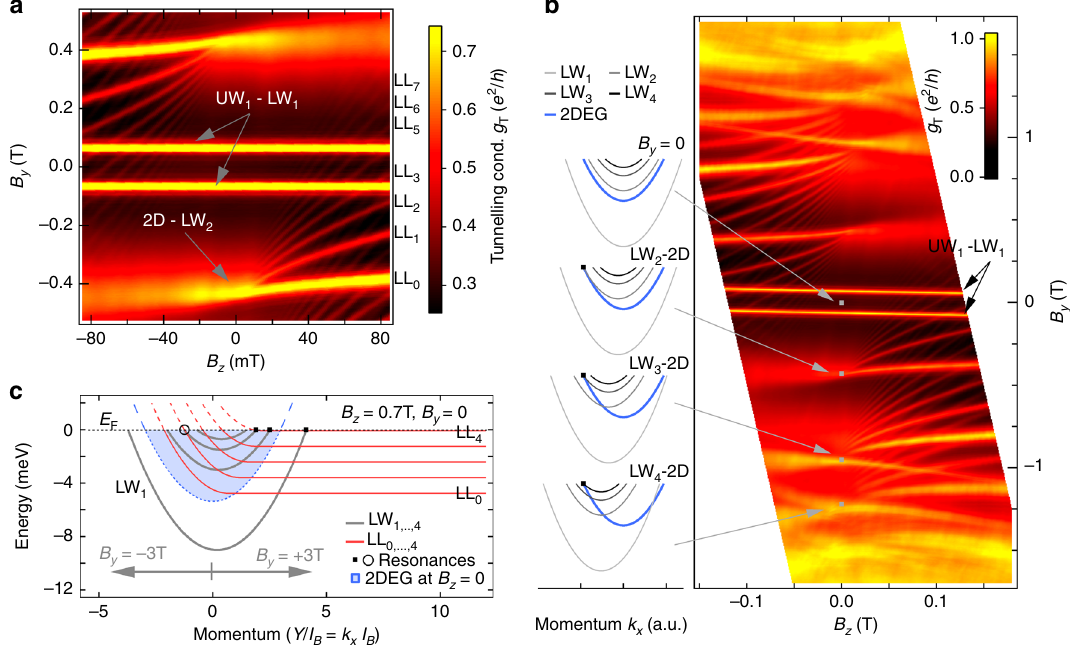
Fig. 2 Formation and B- fi eld evolution of the chiral integer quantum Hall edge states. a Differential tunneling conductance as a function of in-plane magnetic fi eld B y and perpendicular magnetic fi eld B z at ≈ 10 mK. The 2D-wire transitions break up into multiple curves and fan out with increasing | B z |, see (cid:3) (cid:3) (cid:3) (cid:3) , associated with wire-wire tunneling, are not affected by B also Supplementary Fig. 2. Horizontal resonances at small B z . b Larger B y range than a showing y 6 fans corresponding to tunneling to modes LW 2 , LW 3 , and LW 4 . Due to the chiral nature of the states, the fans are not seen in the data when only B z is reversed. The sketches depict the resonance condition (black dots) at B z = 0. c Schematic representation of quantum wire (gray) to LL (red) tunneling at B z = 0.7 T. B fi lled parabola indicates y shifts the lower wire dispersion in relation to the LLs, as indicated by gray arrows of the corresponding length. The blue the 2DEG dispersion for B z = 0, projected onto the k x axis. Black dots and black circle indicate resonant tunneling to bulk states and edge state, respectively NATURE COMMUNICATIONS| (2018) 9:3692 |DOI: